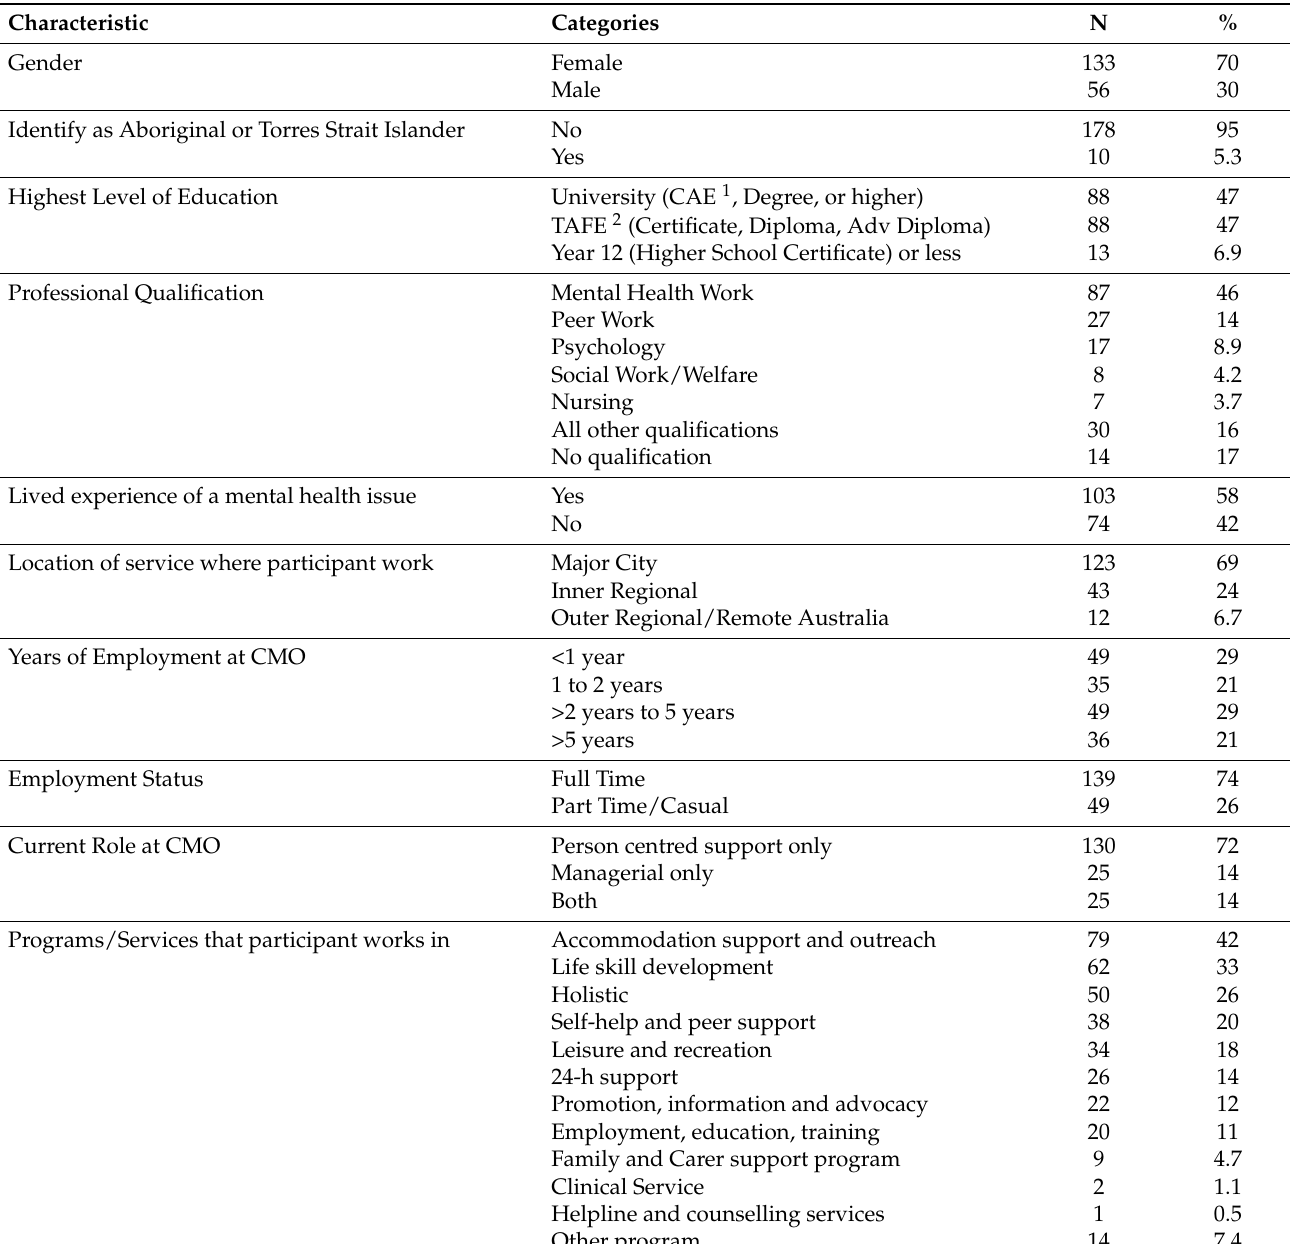
Table 1. Demographic characteristics of CMO staff participants (N =